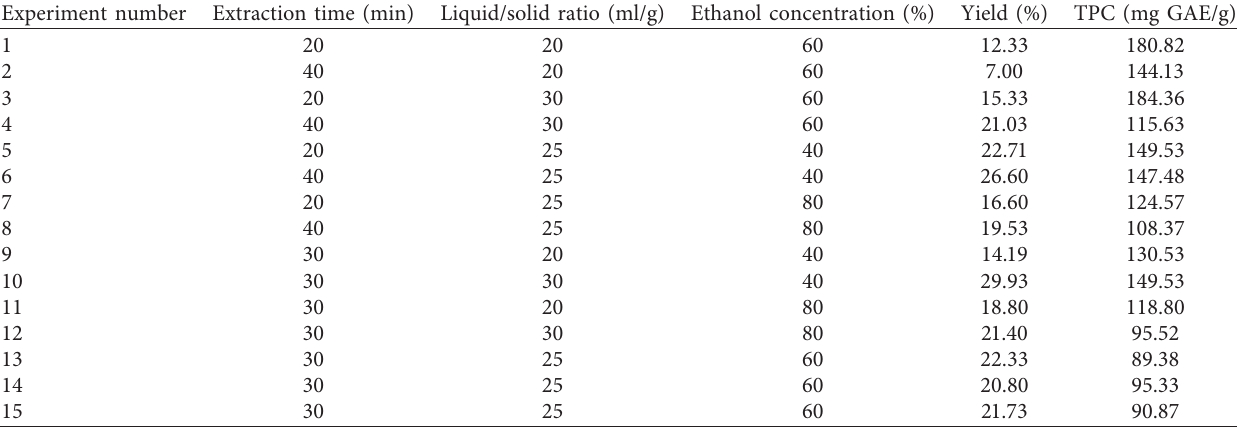
Table 2: Different combinations generated by the Box–Behnken design and the recorded responses for each experiment of L. stoechas